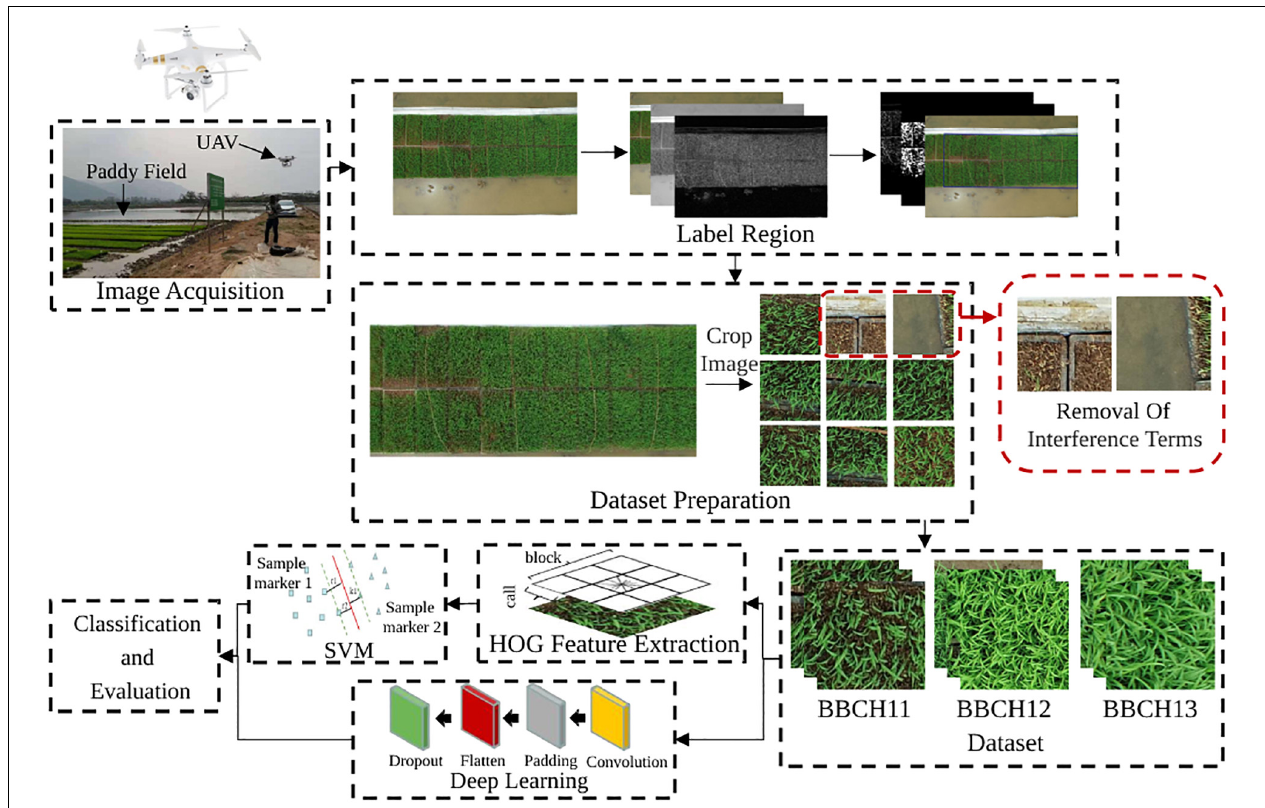
FIGURE 1 | The schematic diagram of the proposed